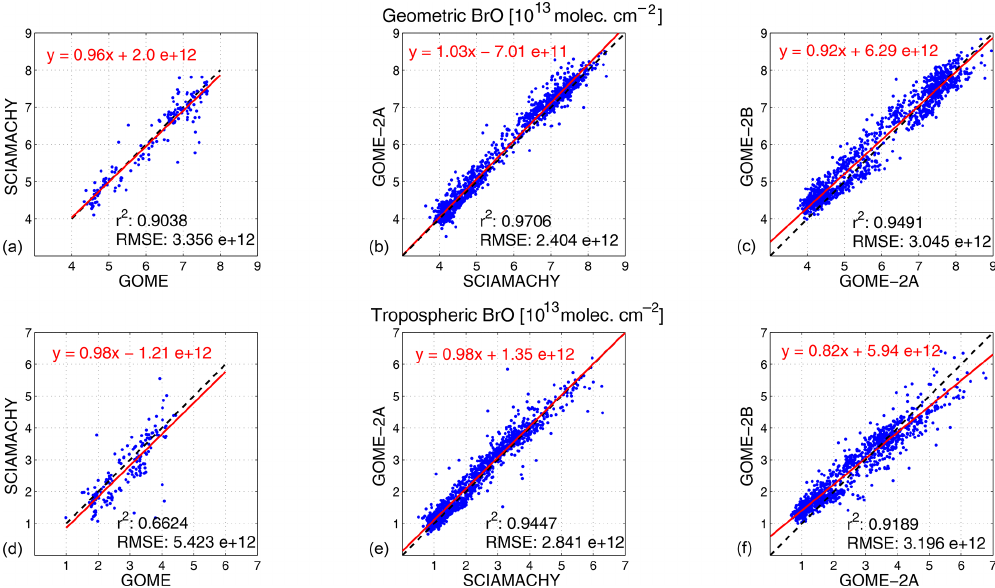
Figure 4. Scatterplots of (a, b, c) geometric BrO VCDs and (d, e, f) tropospheric BrO VCDs for (a, d) GOME against SCIAMACHY (August 2002 to June 2003), (b, e) SCIAMACHY against GOME-2A (March 2007 to March 2012) and (c, f) GOME-2A against GOME-2B (March 2013 to September 2017). The dashed black line in each scatterplot is the reference line, and the red one is the linear regression line. The Pearson correlation coefficient (squared, r 2 ), the RMSE and the y function of the regression line are also given. The units for all scatterplots are (10 13 moleccm − 2 ).